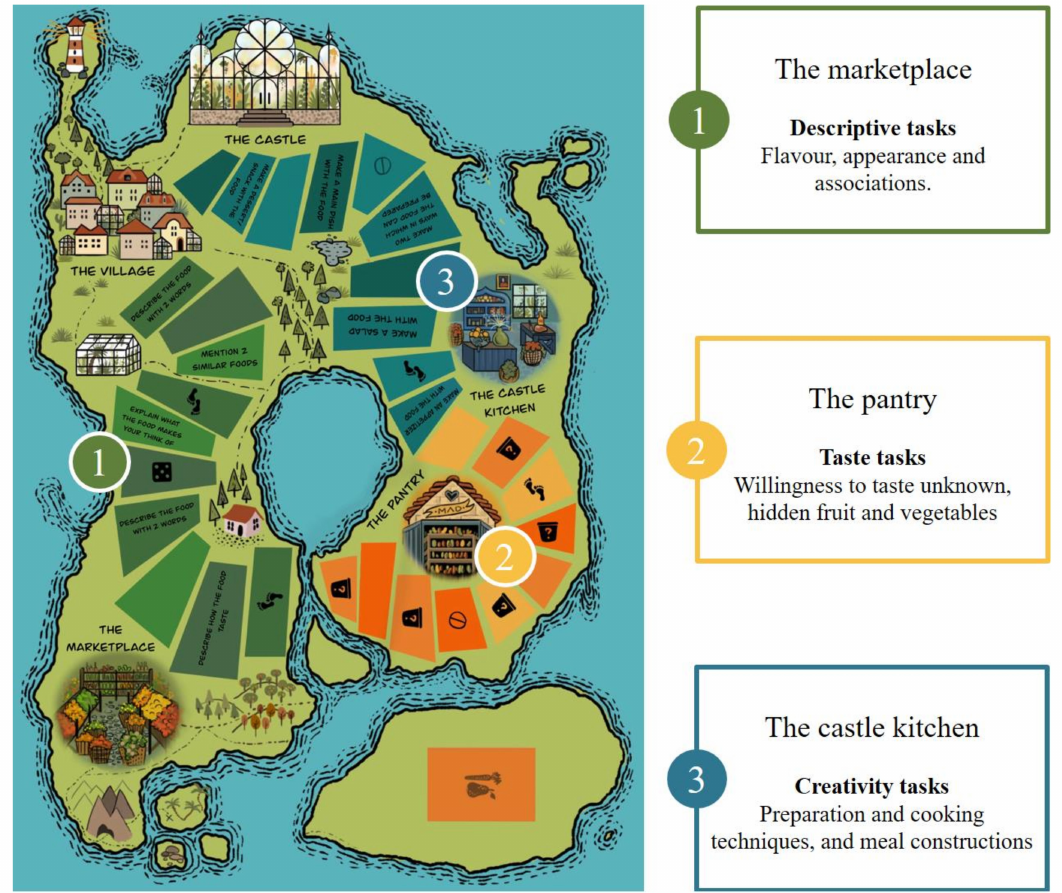
Figure 1. The Kingdom of Taste and an overview of the three zones and their distinctive